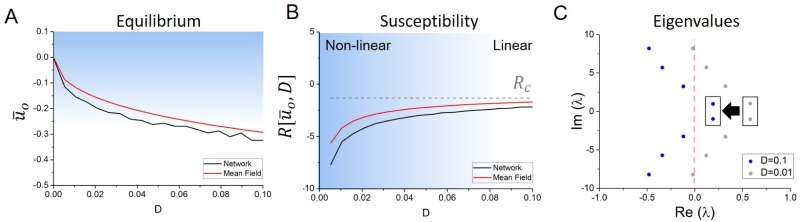
Network stability and equilibrium are shaped by noise.A. Fixed point of the system as per Eq (11) as a function of increasing noise intensity. Noise generically decreases the equilibrium, due to an increased recruitment of recurrent connections. B. Network susceptibility as a function of noise intensity. A gradual shift towards the critical susceptibility Rc occurs under the action of noise, causing the system to transit from slow non-linear oscillations to fast linear oscillations. C. System’s eigenvalues for moderate (D = 0.01) and strong (D = 0.1) noise levels. The eigenvalues gradually shift towards the left hand side of the imaginary plane. Critical eigenvalues (pairs of roots inside the black boxes) translate towards the imaginary axis (Re(λ) = 0) i.e. closer to the critical state. Other parameters are α = 100Hz, β = 2500/mV, g = −2mV/Hz, s = 4mV/Hz, τ = 25ms.